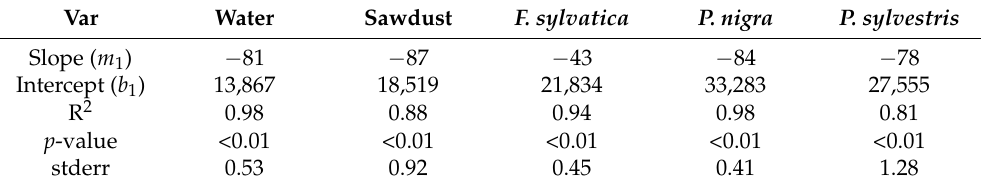
Table 3. Calibration equations to estimate stem volumetric water content for the different samples. Coefficients ‘ 𝛽 0 ’, ‘ 𝛽 1 ’, and ‘ 𝛽 2 ’ are presented for multiple linear equations in the standard form: 𝑠𝑡𝑒𝑚 𝑉𝑊𝐶 (%) = 𝛽 0 + 𝛽 1 × 𝑇 + 𝛽 2 × 𝐸𝐶𝑓 . Scheme 2